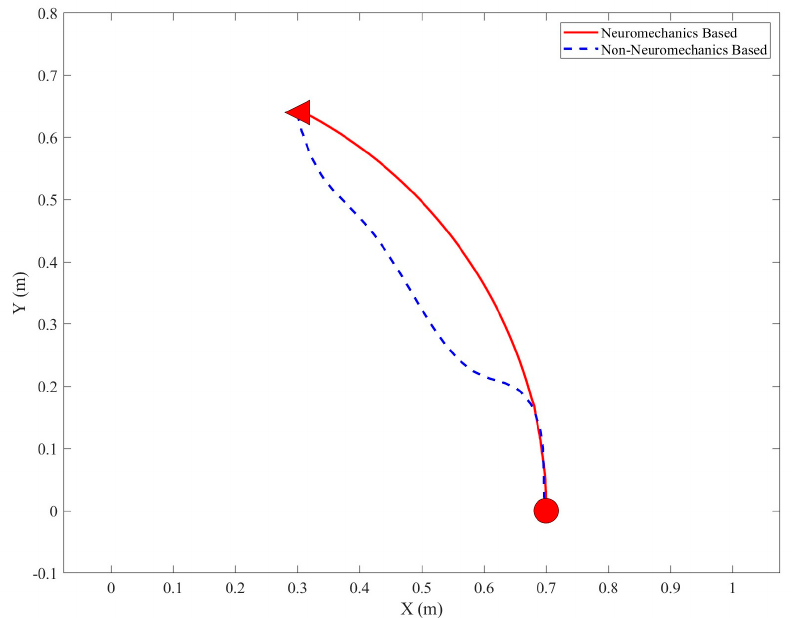
Figure 7. Movement trajectories (start from (0.7,0) and end at (0,0.7)) generated by the musculoskeletal arm under neuromechanics—based and non—neuromechanics—based neural feedback controllers.